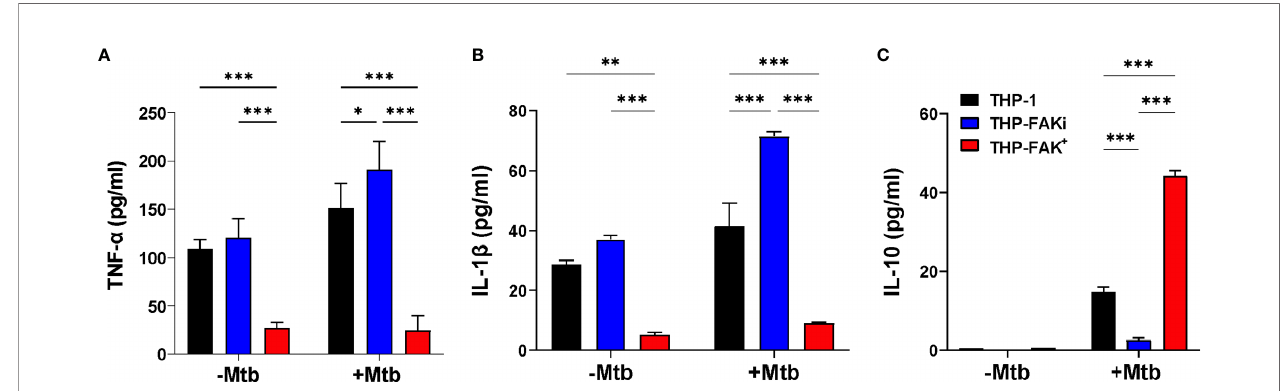
FIGURE 3 | FAK expression alters cytokine production by macrophages infected with Mtb. THP-1, THP-FAKi and THP-FAK + macrophages were infected with Mtb at an MOI of 10 and cell culture supernatants were collected at 24 hours post-infection. Production of (A) TNF- a (B) IL-1 b (C) IL-10 were measured in cell culture supernatants using a human ELISA assay kit. Error bars represent the mean ± SD of three independent biological replicates. * p < 0.05, ** p < 0.01, *** p <